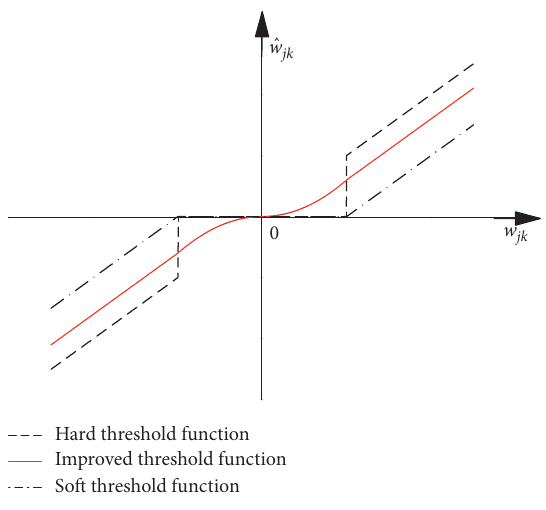
Figure 4: Improved threshold function